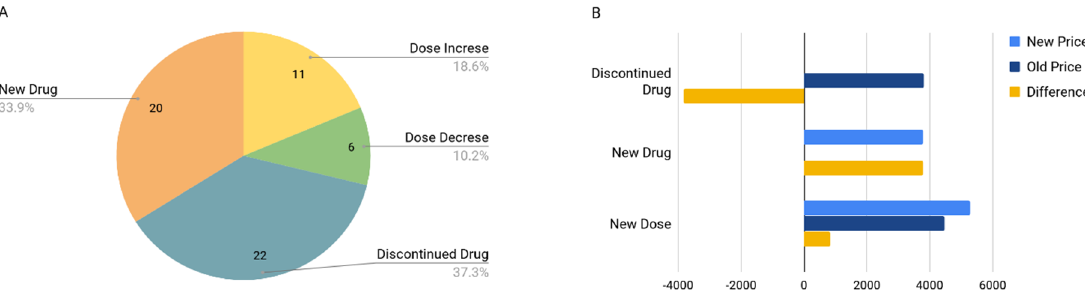
Figure 5. ( A ) Breakdown of therapy changes made by type of change, N = 59; ( B ) Cost-benefit of drug changes—shows drug cost changes by type of therapy change. Bars represent total cost in CAD.